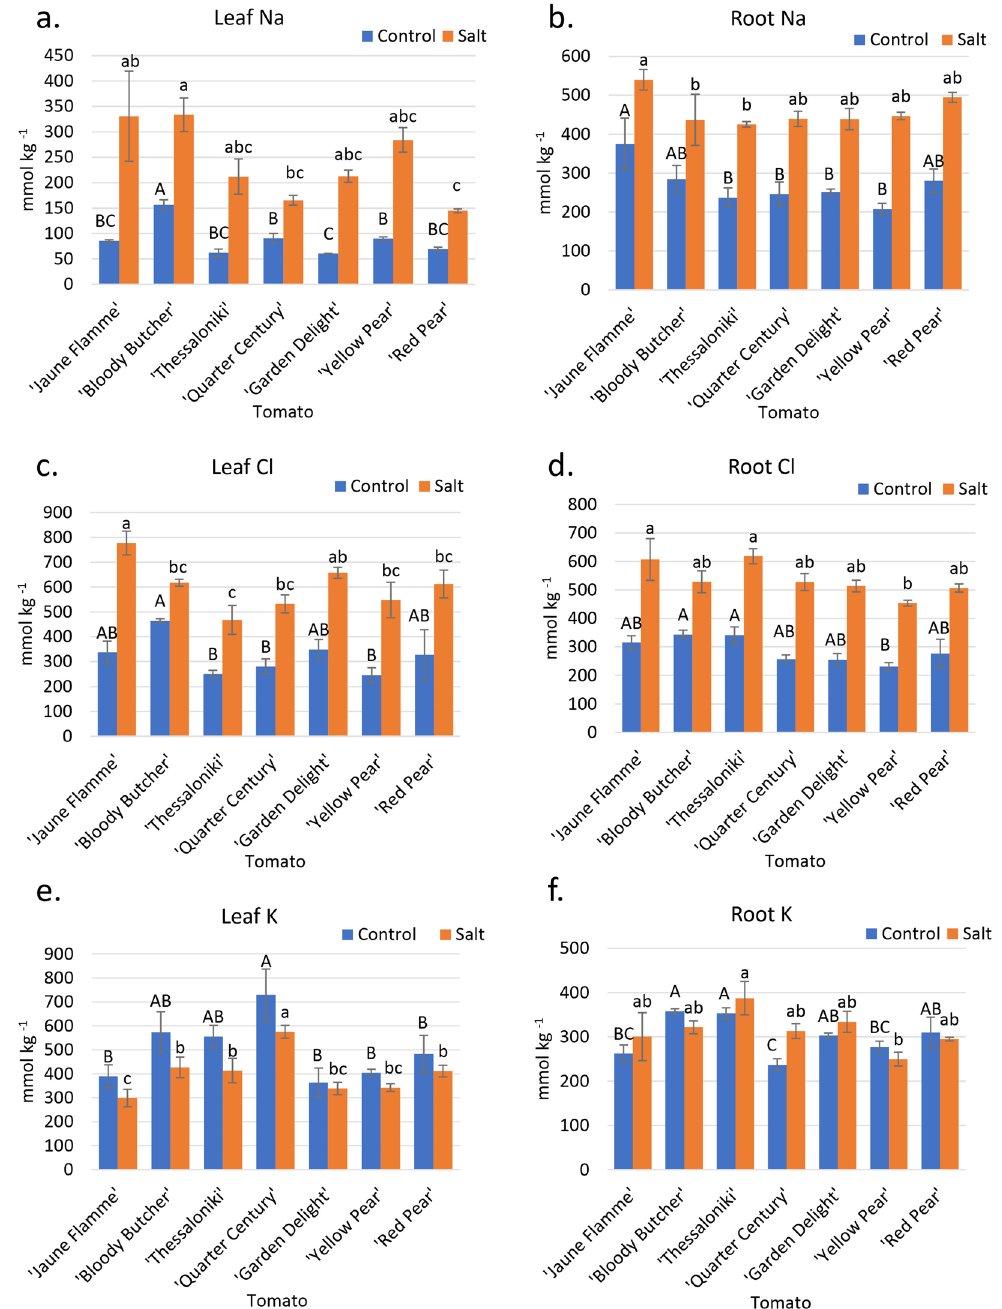
Figure 3. Tissue ion concentrations of seven tomato cultivars irrigated with control and saline irrigation waters. ( a ) Leaf Na concentrations. ( b ) Root Na concentrations. ( c ) Leaf Cl concentrations. ( d ) Root Cl concentrations. ( e ) Leaf K concentrations. ( f ) Root K concentrations. Capital letters denote differences among cultivars under control conditions, while lowercase letters denote significant differences under saline conditions ( p < 0.05). Error bars represent standard